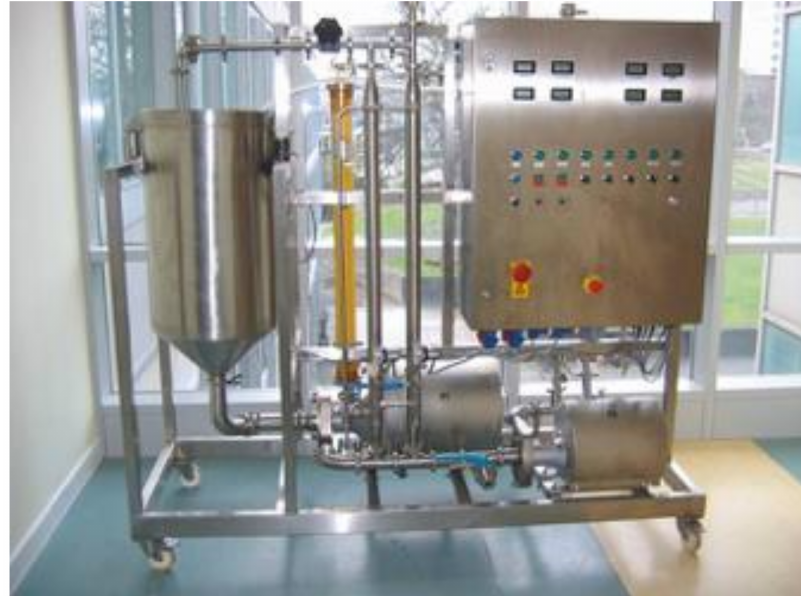
Figure 1. Swansea University ceramic pilot microfiltration membrane rig.